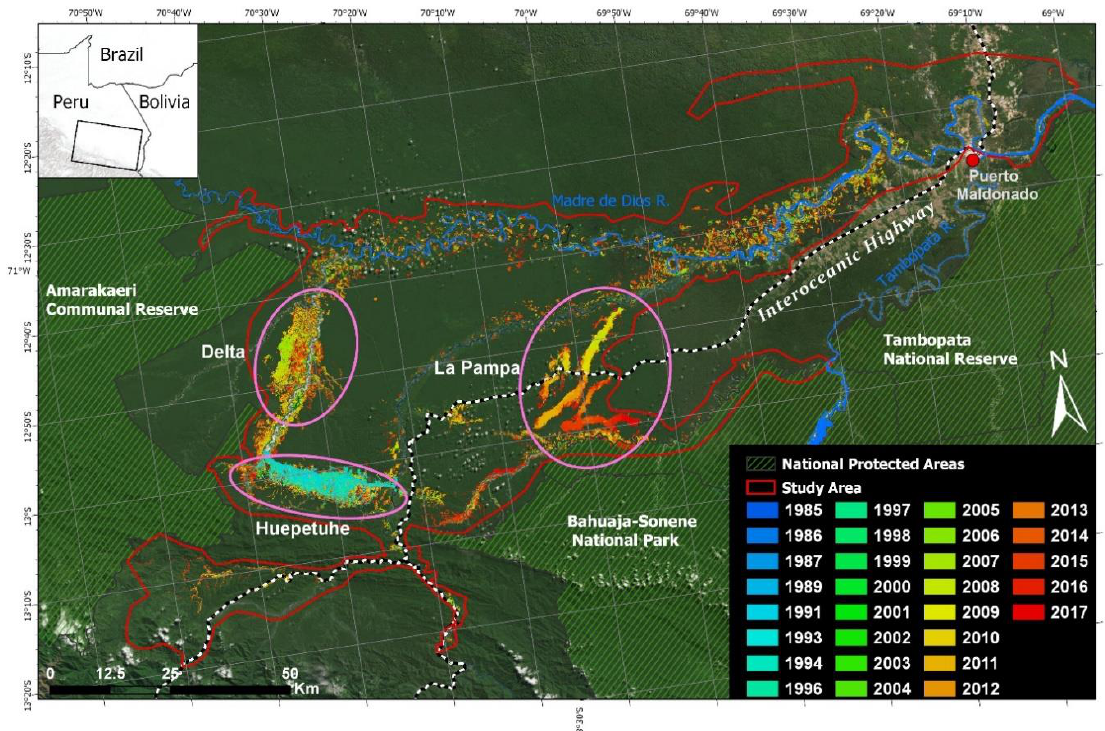
Figure 1. Geography of artisanal scale gold mining (ASGM) and annual deforestation caused by ASGM in SE Peru. The mining zone considered in this study is outlined in red, with areas of intensive mining circled in blue. Dashed line is the Interoceanic Highway, and hatched areas denote lands with national protected status. Colored areas indicate deforestation due to mining, with the year that land was first deforested displayed on a color ramp going from blue (1984–1985) to red (2016–2017). Basemap imagery from ESRI [24].